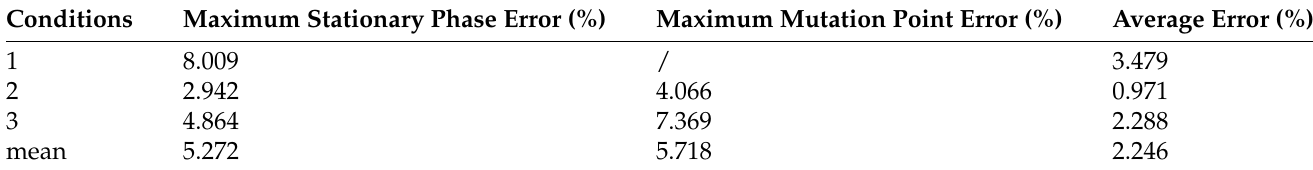
Table 4. Full-scale experimental error statistics table.